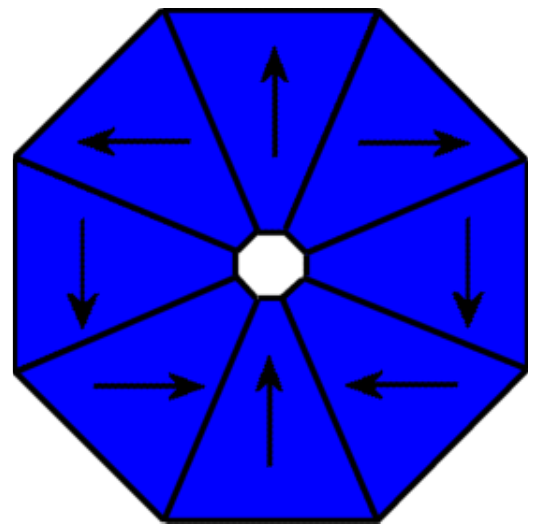
FIG. 2. (Color) Schematic showing the magnetization vectors of a dipole ring comprised of 8 magnet blocks. For 8 blocks in a ring, the magnetization vector must be rotated by 90 (cid:5) from block to block to produce a dipole field on-axis.